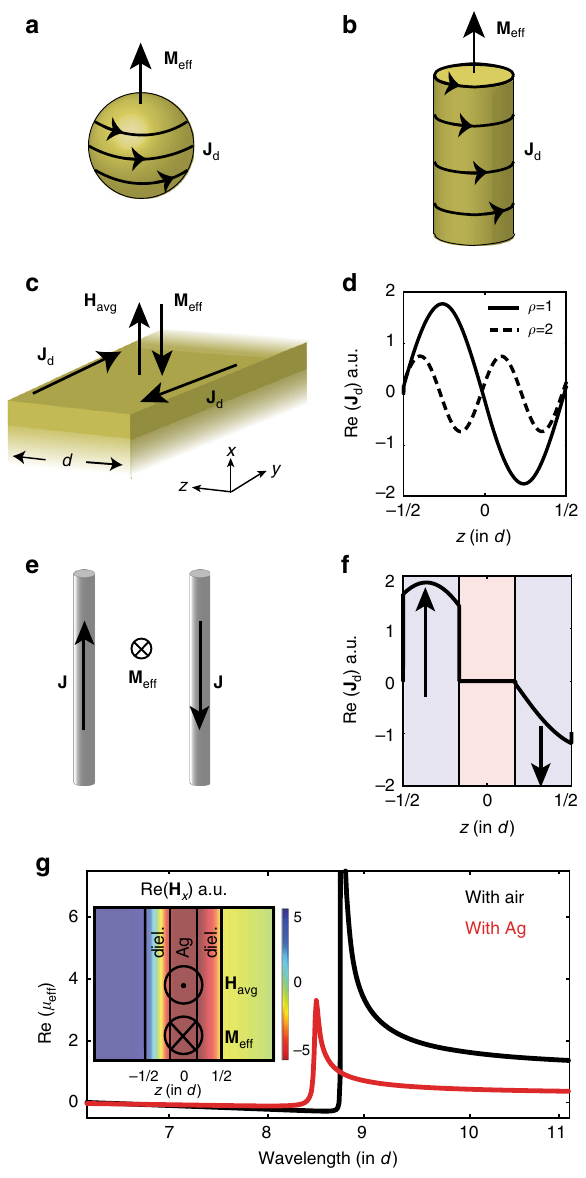
Fig. 2 Concept of arti fi cial magnetism in 3D, 2D, and 1D structures. A circulating current fl ow J d induces a magnetization M eff in all three cases: a dielectric nanoparticles (three-dimensional metamaterials), b dielectric nanorods (two-dimensional metamaterials), and c one-dimensional dielectric slabs. H avg is the average magnetic fi eld, which faces in the direction opposite to M eff . d Displacement current distribution at resonance for ρ = 1, ρ = 2, for a 90 nm slab of refractive index n diel = 4.5. e Two in fi nite wires carrying opposite currents are equivalent to f two dielectric layers (blue shaded regions) separated by air (pink shaded region) in terms of their current distribution. Arrows in f indicate the direction of J d , which is anti-symmetric at resonance. g Effective permeability for two dielectric layers separated by air and silver. Inset: tangential magnetic fi eld distribution at resonance: average magnetic fi eld is opposite to M